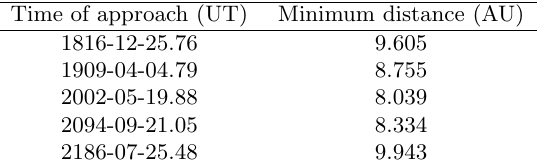
Fig. 4. The same as in Figure 3 but for 185 Centaurs and SDOs with semimajor axes smaller than 50 AU. Table 4. Close approaches of 2012 DS85 with